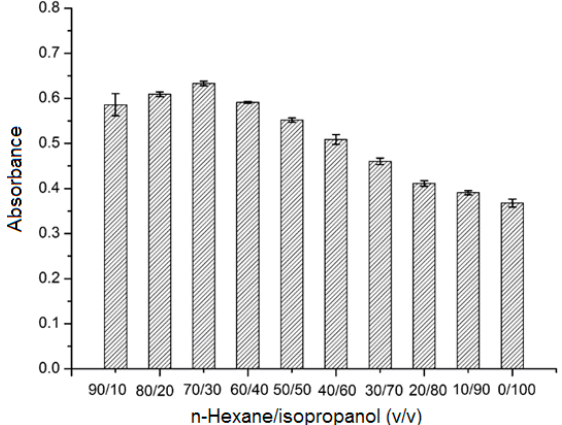
Figure 4. Effect of solvent composition. Analyte concentration: 3.0 mmol L − 1 ; sample volume: 2.0 mL; and elution solvent: methanol (4 mL).